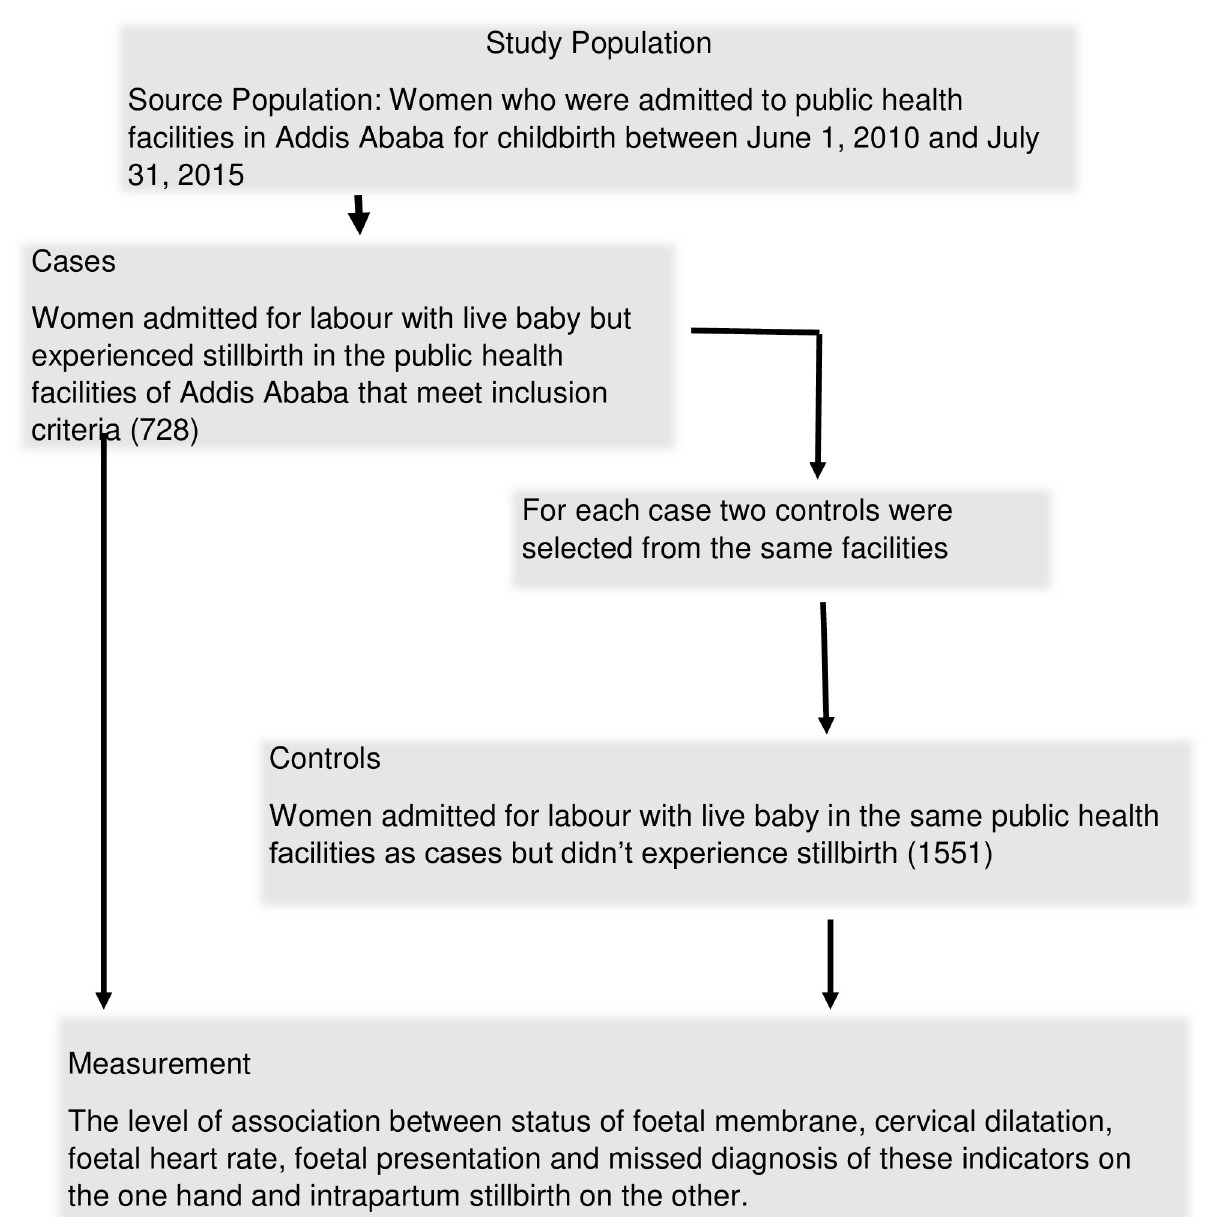
Fig 1. Flowchart depicting selection process of cases and control from the study population. Schematic presentation of sample selection process from the study population.